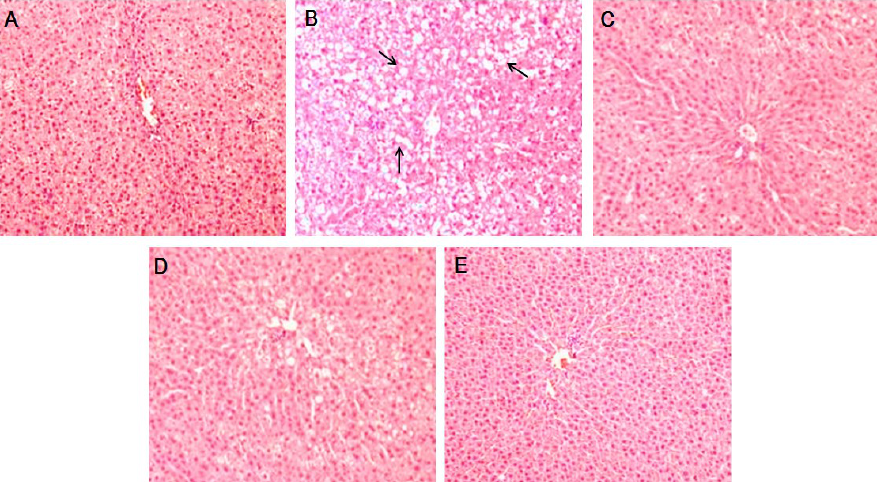
Figure 3. Histological images of liver tissues from OVX-induced hepatic steatosis displaying the hepatoprotective effects of PTIF. There were no histological abnormalities observed in sham rats ( A ). OVX-induced hepatic steatosis showing hepatocytes with severe cytoplasmic vacuoles and swelling ( B ). E2 10 μg/kg resulted in the prevention of hepatic fatty deposition in hepatocytes ( C ). The treatments with PTIF 30 and 100 mg/kg resulted in the prevention of hepatic fatty deposition in hepatocytes ( D , E ). The tissues were surgically excised and subjected to histological study by staining with hematoxylin and eosin (H & E). All magnifications: 200×. The arrows indicate fatty